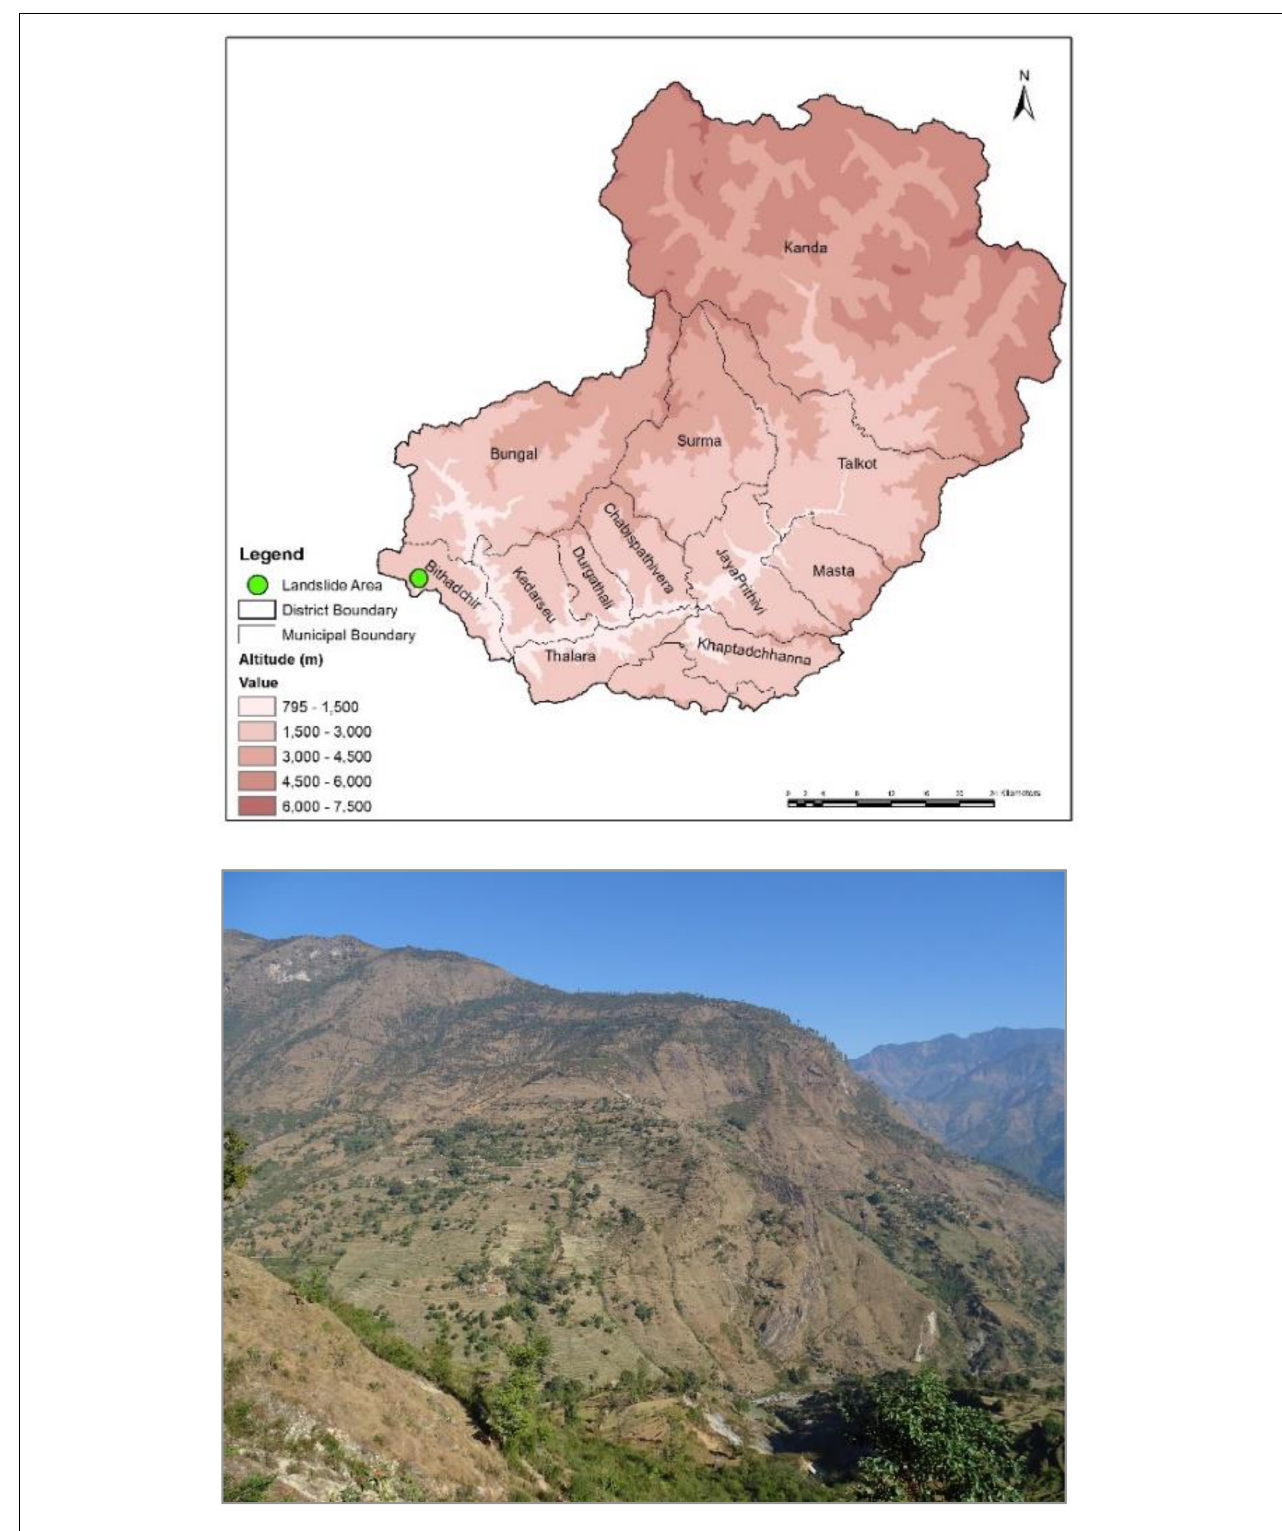
FIGURE 1 | The Sunkuda Landslide in Bajhang.